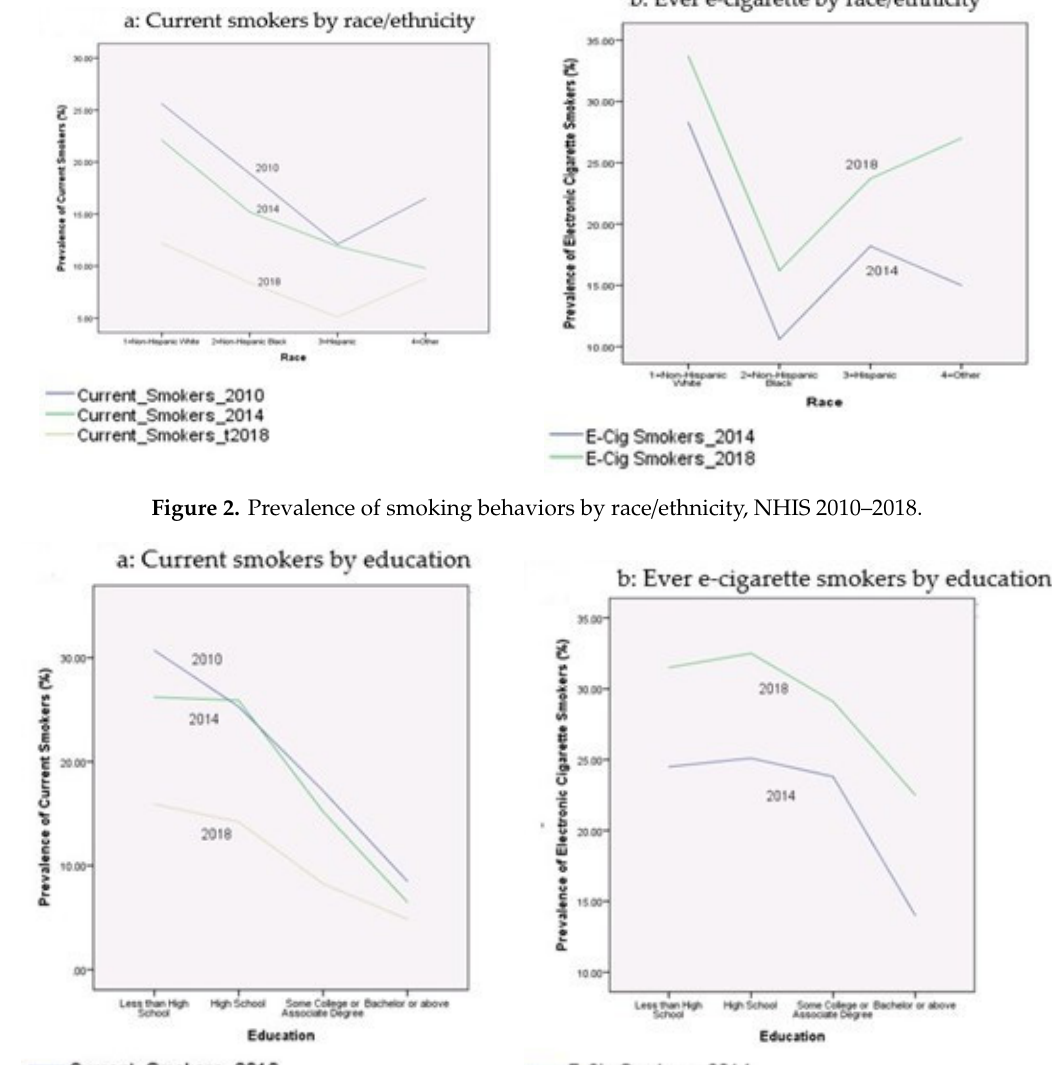
Figure 1. Prevalence of smoking behaviors by age, NHIS 2010–2018.